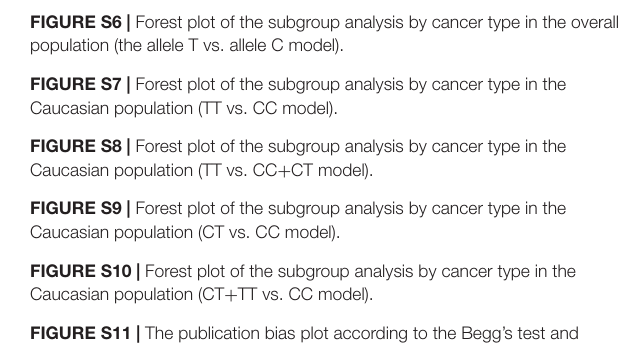
FIGURE S1 | Forest plot of the meta-analysis in the overall population (allele T vs. allele C model). FIGURE S2 | Forest plot of the meta-analysis in the overall population (carrier T vs. carrier C model). FIGURE S3 | Forest plot of the meta-analysis in the overall population (CT vs. CC model). FIGURE S4 | Forest plot of the meta-analysis in the overall population (CT + TT vs. CC model). FIGURE S5 | Forest plot of the subgroup analysis by control source in the overall population (TT vs. CC model). FIGURE S6 | Forest plot of the subgroup analysis by cancer type in the overall population (the allele T vs. allele C model). FIGURE S7 | Forest plot of the subgroup analysis by cancer type in the Caucasian population (TT vs. CC model). FIGURE S8 | Forest plot of the subgroup analysis by cancer type in the Caucasian population (TT vs. CC + CT model). FIGURE S9 | Forest plot of the subgroup analysis by cancer type in the Caucasian population (CT vs. CC model). FIGURE S10 | Forest plot of the subgroup analysis by cancer type in the Caucasian population (CT + TT vs. CC model). FIGURE S11 | The publication bias plot according to the Begg’s test and sensitivity analysis data for the Caucasian population under the models of TT vs. CC and TT vs. CC + CT. (A,B) Begg’s test; (C,D) sensitivity analysis. FIGURE S12 | The publication bias plot according to the Begg’s test and sensitivity analysis data for the Caucasian population under the models of CT vs.